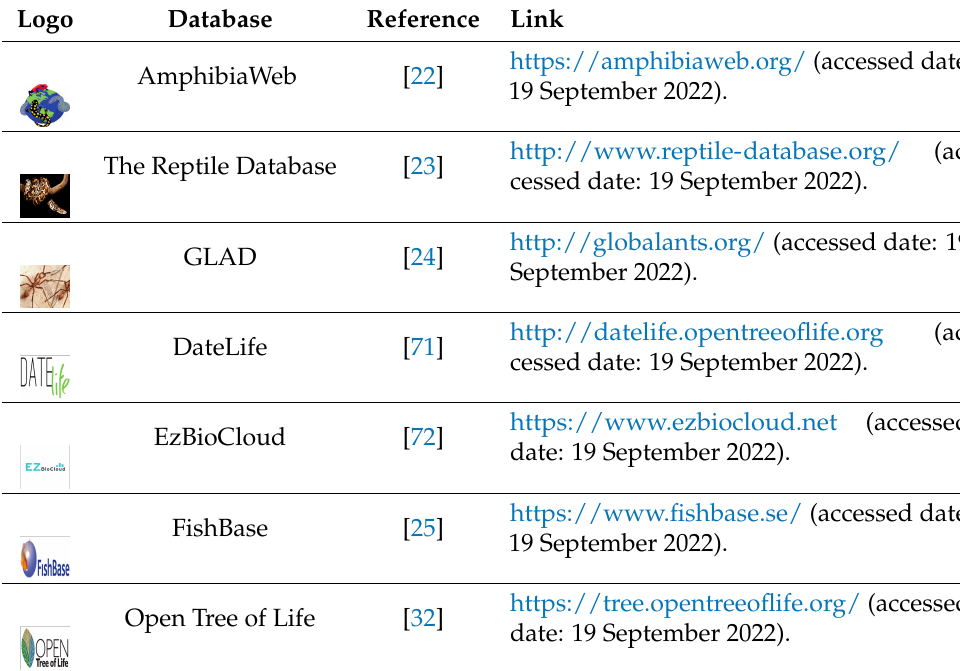
Table A1. Online databases for phylogenetic trees and trait data